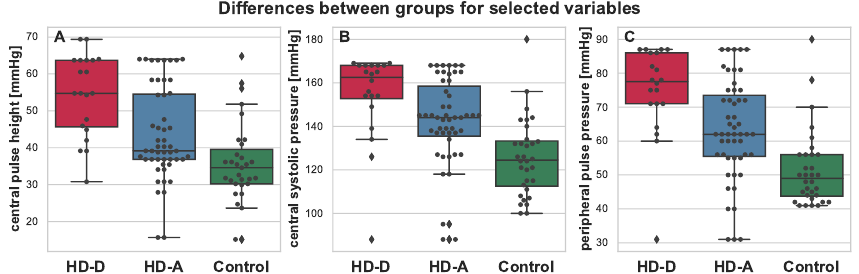
Figure 5. Boxplot depicting differences between HD-D (red), HD-A (blue), and Control (green) for the chosen variables: central pulse height ( A ), central systolic pressure ( B ), and peripheral pulse pressure ( C ). Additional swarmplot was overlaid onto the original plot in order to mark the obtained measurements for each of the patients (dots). Outlier values are represented by